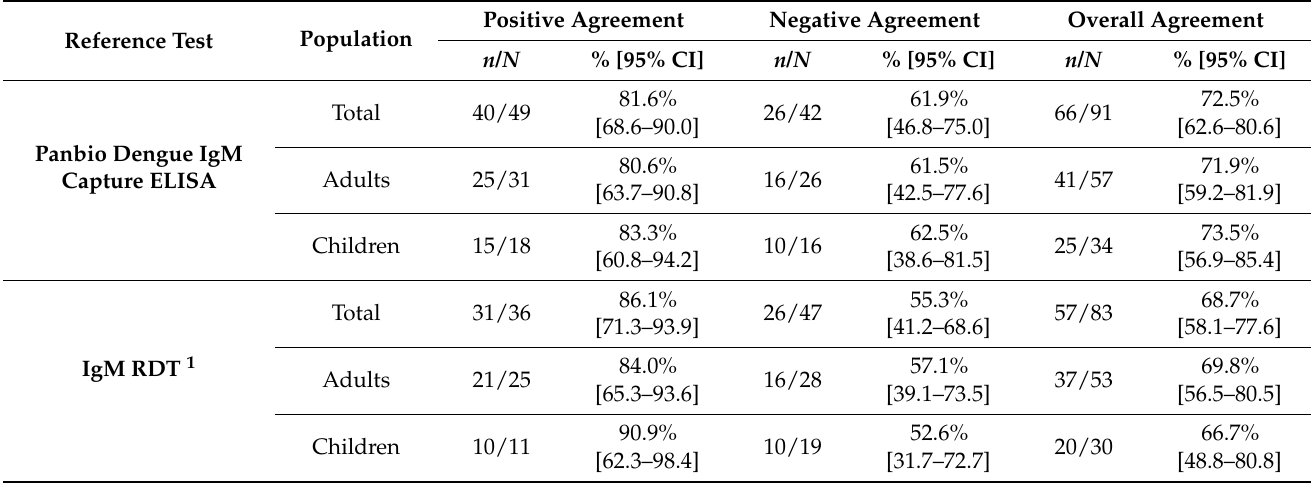
Table 4. Concordance of VIDAS ® Anti-Dengue IgM and competitor assays.